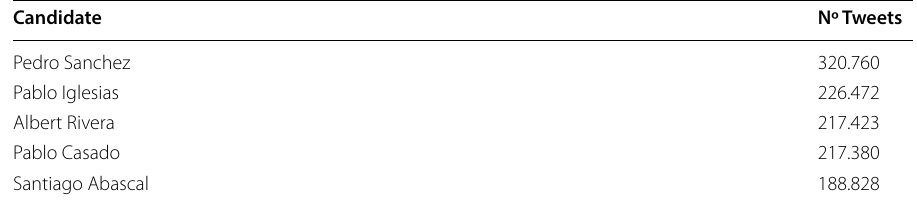
Table 1 Classification of the keywords by political faction